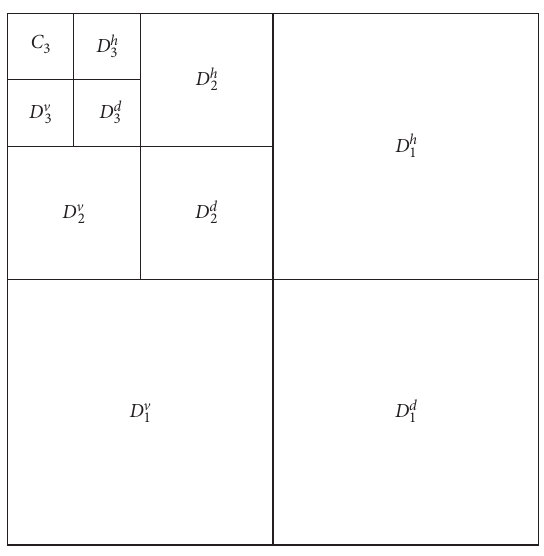
Figure 5: Wavelet decomposition diagram (three